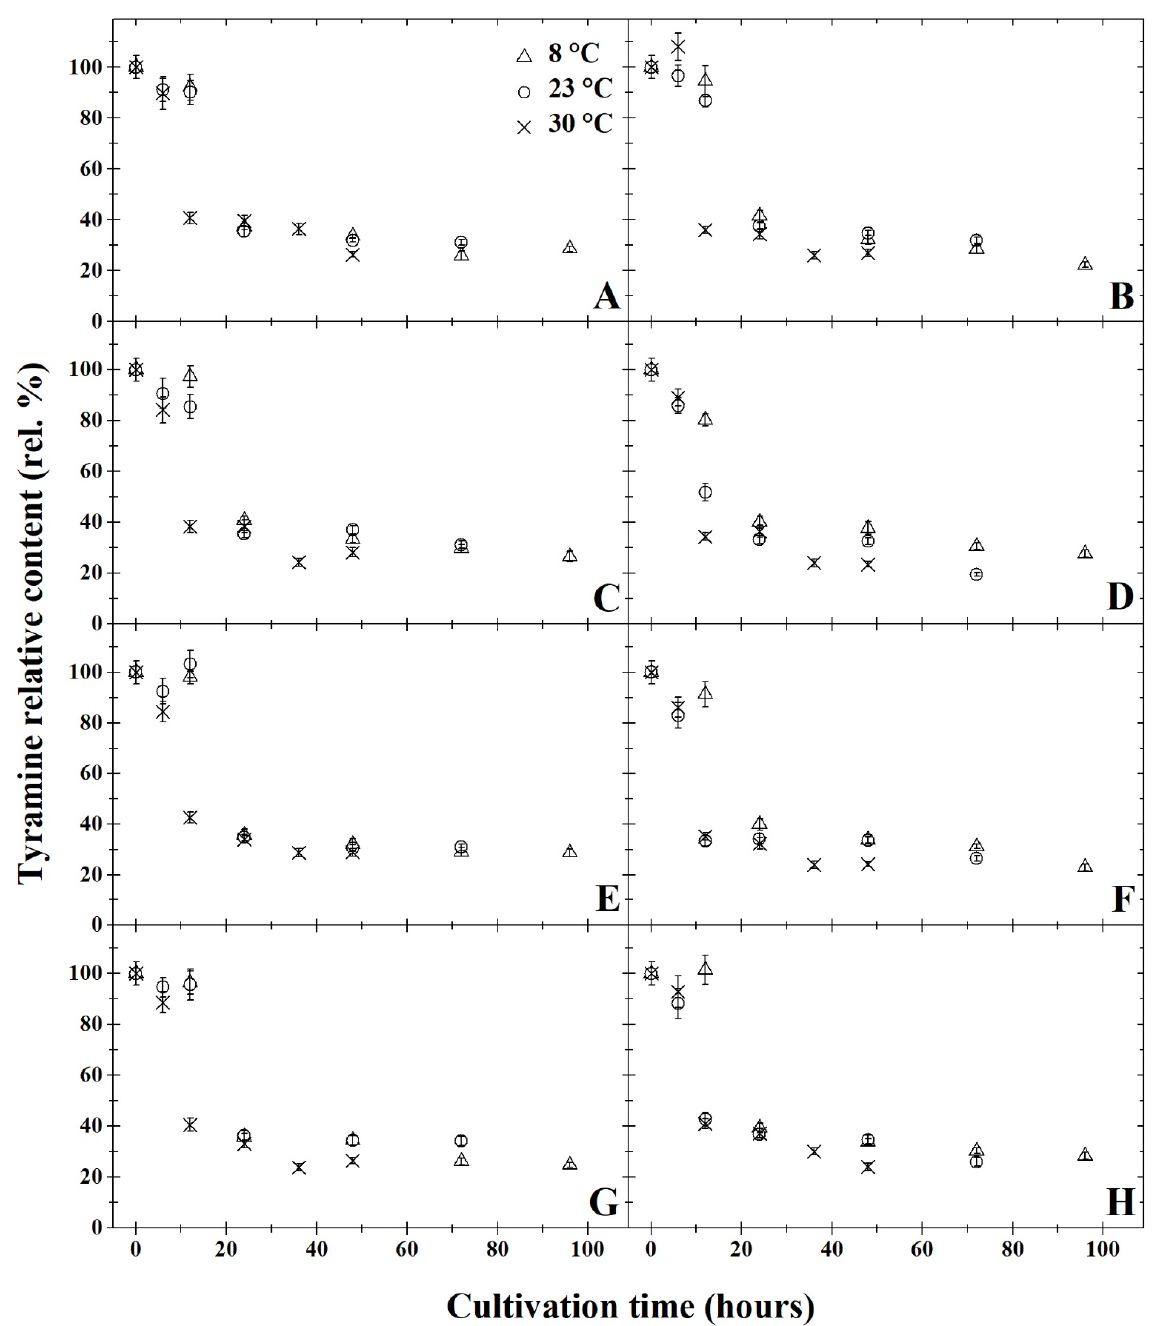
Figure 5. Development of tyramine relative content (rel. %) by degradation using Bacillus subtilis DEPE IB1 in dependence on the cultivation time (hours); the initial tyramine relative content at the time zero were always 100%. Parts ( A , C , E , G ) represent the results of anaerobic cultivation and parts ( B , D , F , H ) show the results of aerobic cultivation. Incubation was carried out under pH = 5 (parts A and B ), pH = 6 (parts C and D ), pH = 7 (parts E and F ), pH = 8 (parts G and H ). Three cultivation temperatures were used: 8 °C ( ), 23 °C ( ) and 30 °C ( ). The results were presented using the means and standard deviations (bars; n = 24).